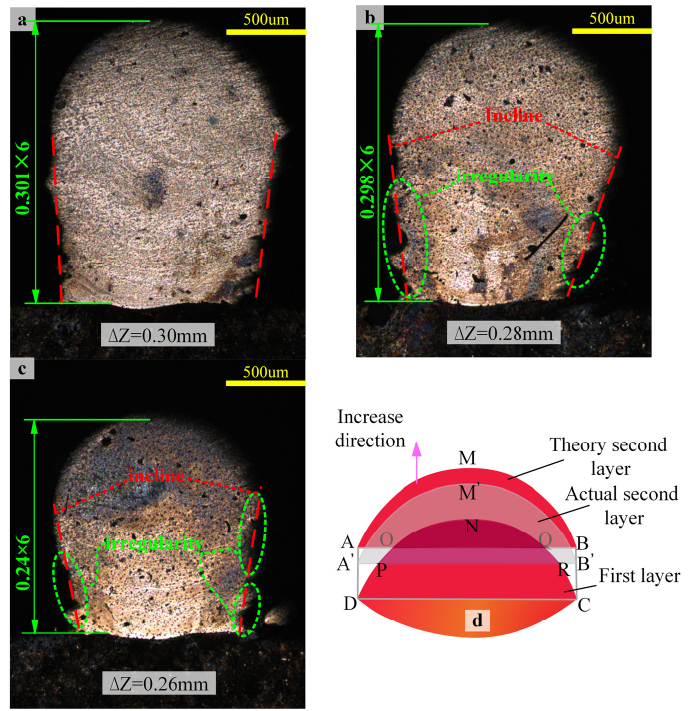
Figure 9. Micrograph of the cross-section of the longitudinal